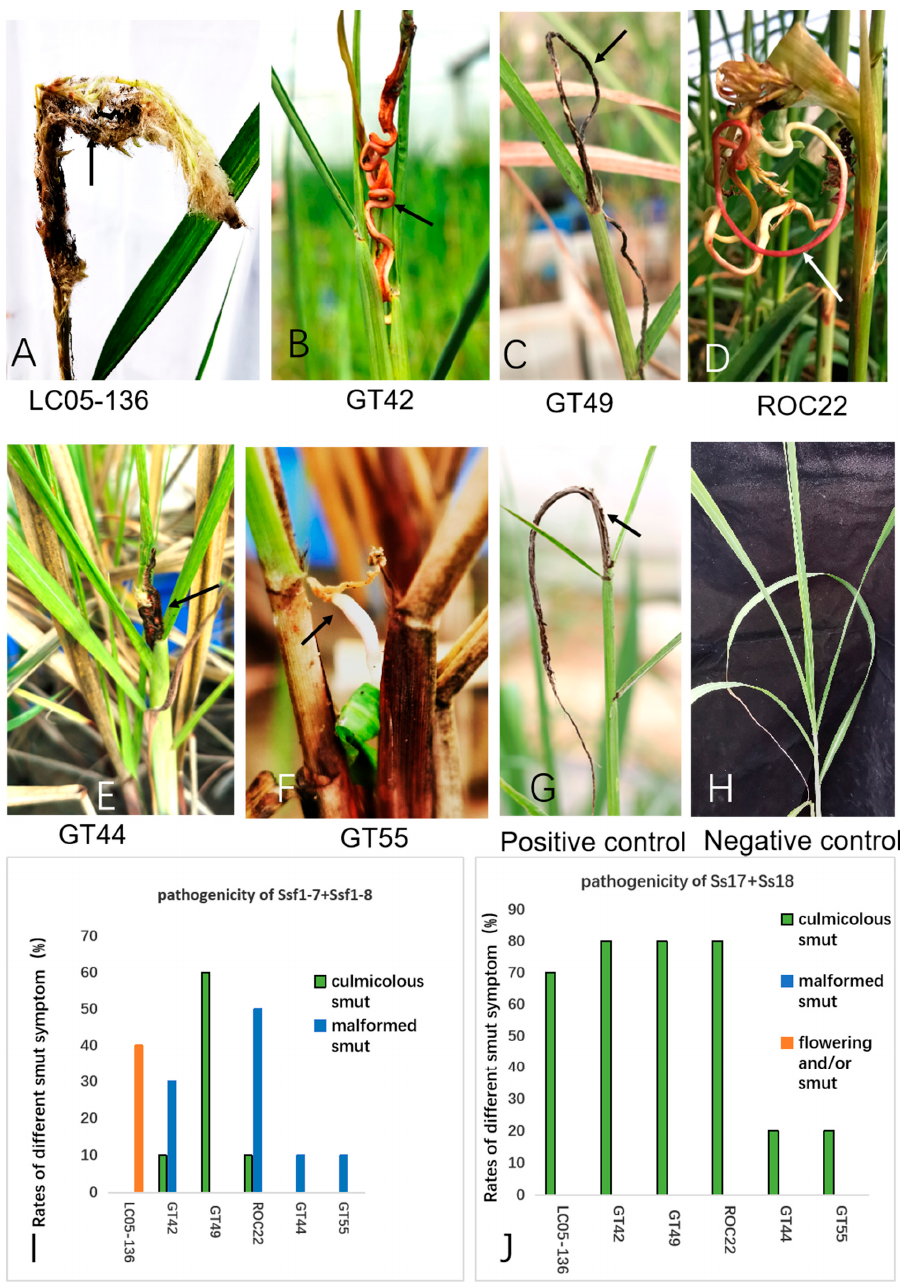
Figure 3. Smut symptoms in different sugarcane varieties. ( A – F ): Smut symptoms (arrows) in sugarcane varieties, i.e., LC05-136, GT42, GT49, ROC22, GT44 and GT55, respectively, which was inoculated by fungus cells of the mixture of the isolates of Ssf1-7 and Ssf1-8 from fluorescence smut. ( G ): Characteristic smut symptom (arrows) in sugarcane on the top of stalk inoculated with the mixture of Ss17 and Ss18. ( H ): negative control. ( I ): Smut rates in different sugarcane varieties inoculated smut fungus mixture of Ssf1-7 + Ssf1-8. ( J ): Frequency of smut symptoms development in different sugarcane varieties inoculated smut fungus mixture of Ss17 +